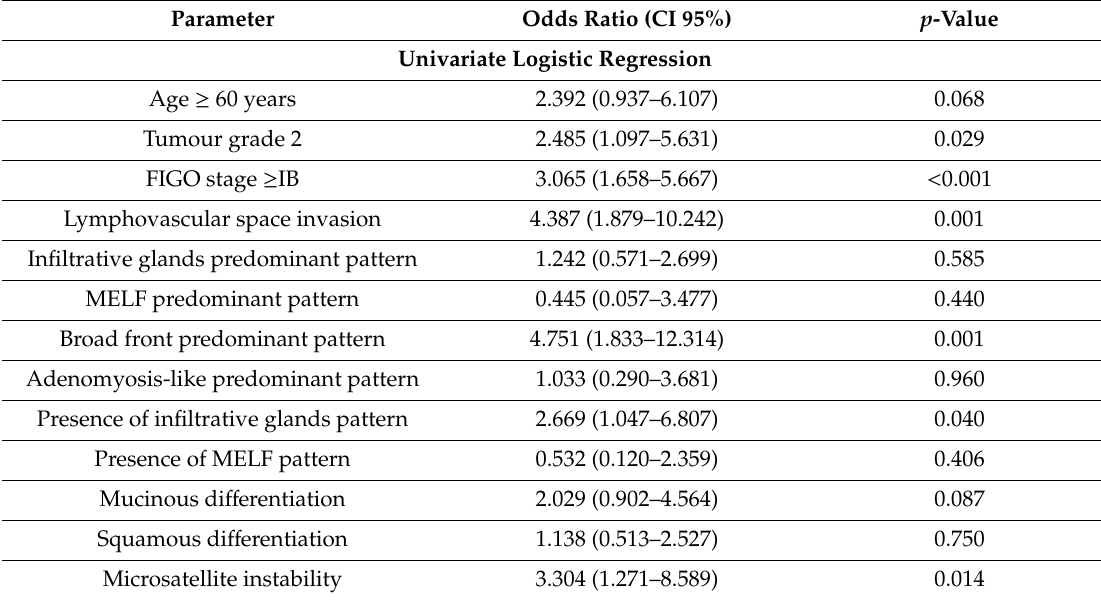
Table 3. Univariate analyses of odds ratios in the logistic regression model with relapse as the dependent variable.